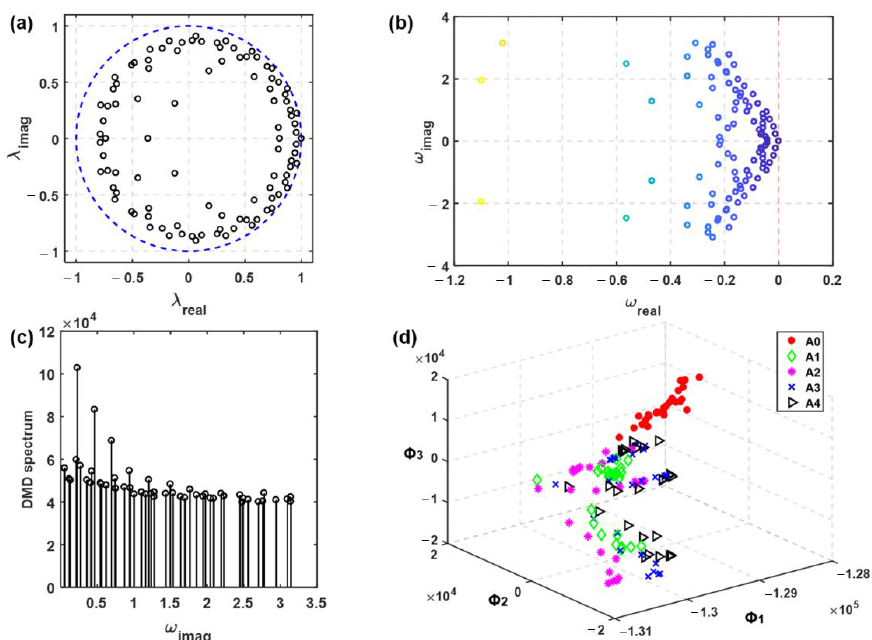
Figure 15. DMD analysis of exhaled aerosol images in the test case 3: ( a ) DMD eigenvalues λ, ( b ) transformed eigenvalues ω = log(λ)/(2π), ( c ) DMD energy spectrum, and ( d ) eigenspace spanned ( b ) transformed eigenvalues ω = log( λ )/(2 π ), ( c ) DMD energy spectrum, and ( d ) eigenspace spanned by the first three DMD eigenvectors. by the first three DMD